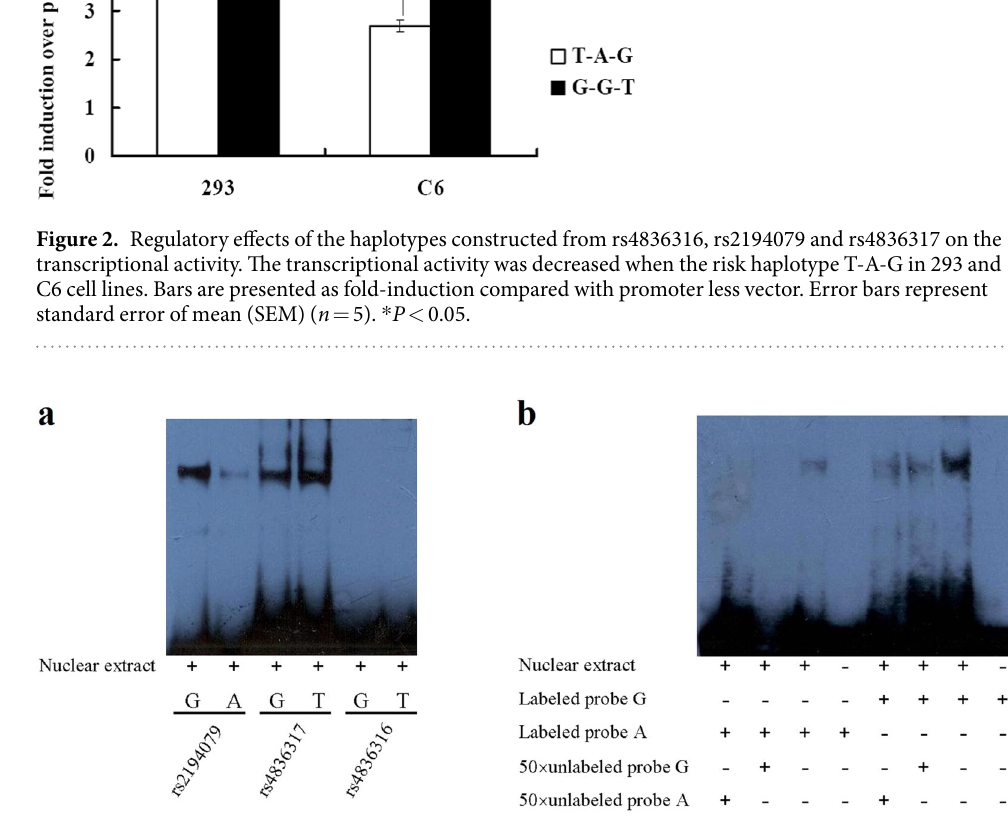
Figure 3. Results of electrophoretic mobility shift assays for rs4836316, rs2194079 and rs4836317. Electrophoretic mobility shift assays were performed with biotinylated oligonucleotides and nuclear extracts isolated from C6 cell line to investigate the binding of associated SNP with nuclear extract. ( a ) The labeled probes containing variants of rs2194079, rs4836316, rs4836317 were incubated with the nuclear proteins. SNP rs4836316 showed no band shift. Both rs2194079 and rs4836317 showed band shifts. The allele G of rs2194079 showed preferential binding with the nuclear extract. ( b ) Specificity was determined by competition with